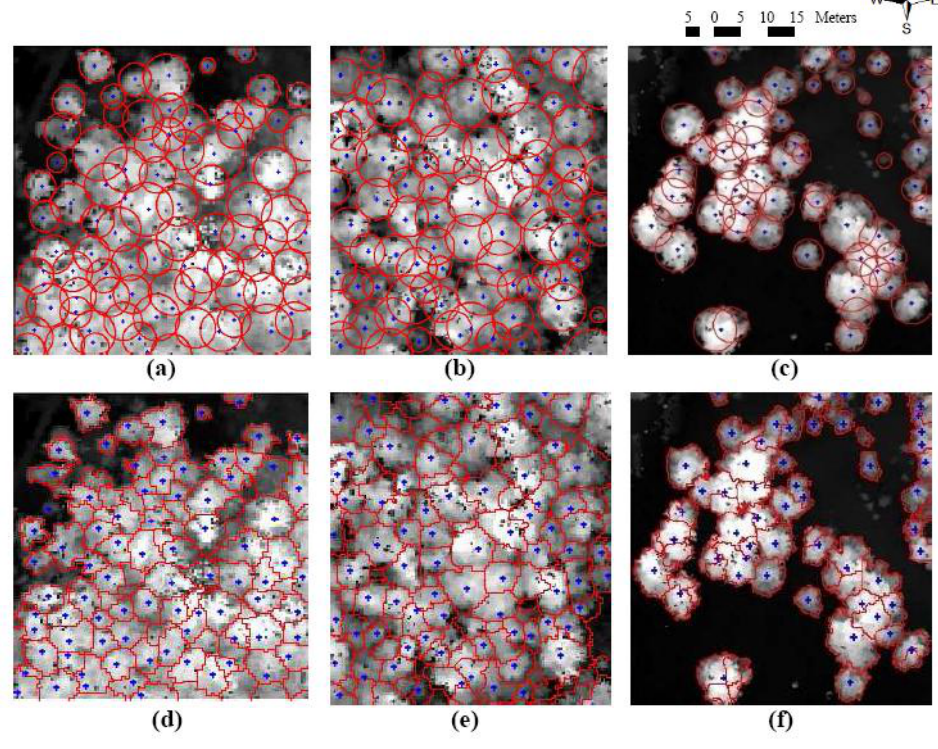
Figure 5. The extracted mangrove crown (red boundary) based on LiDAR measurements by the VWF ( a ), ( b ), ( c ) and IWS ( d ), ( e ), ( f ) methods of plots 1, 2, and 3, respectively, overlaid on the raster CHM, and compared with the reference locations based on field measurements (blue